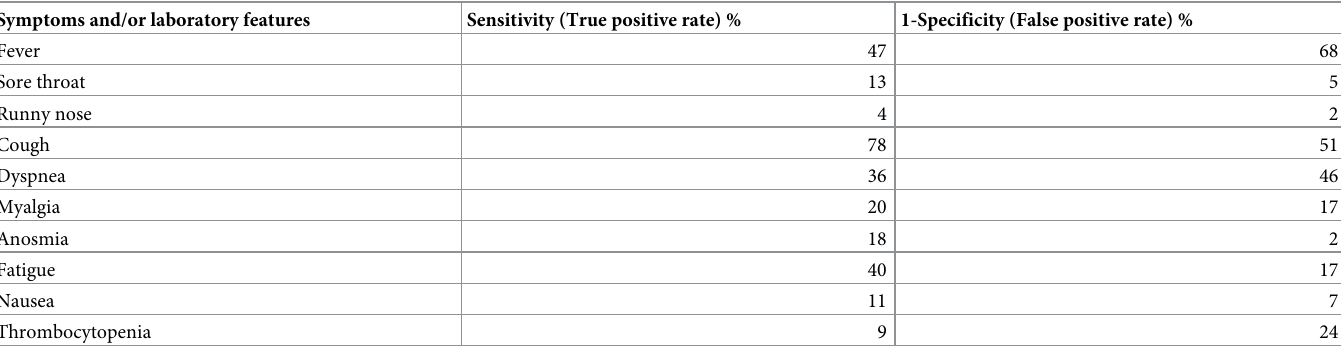
Table 7. True positive and false negative rate.